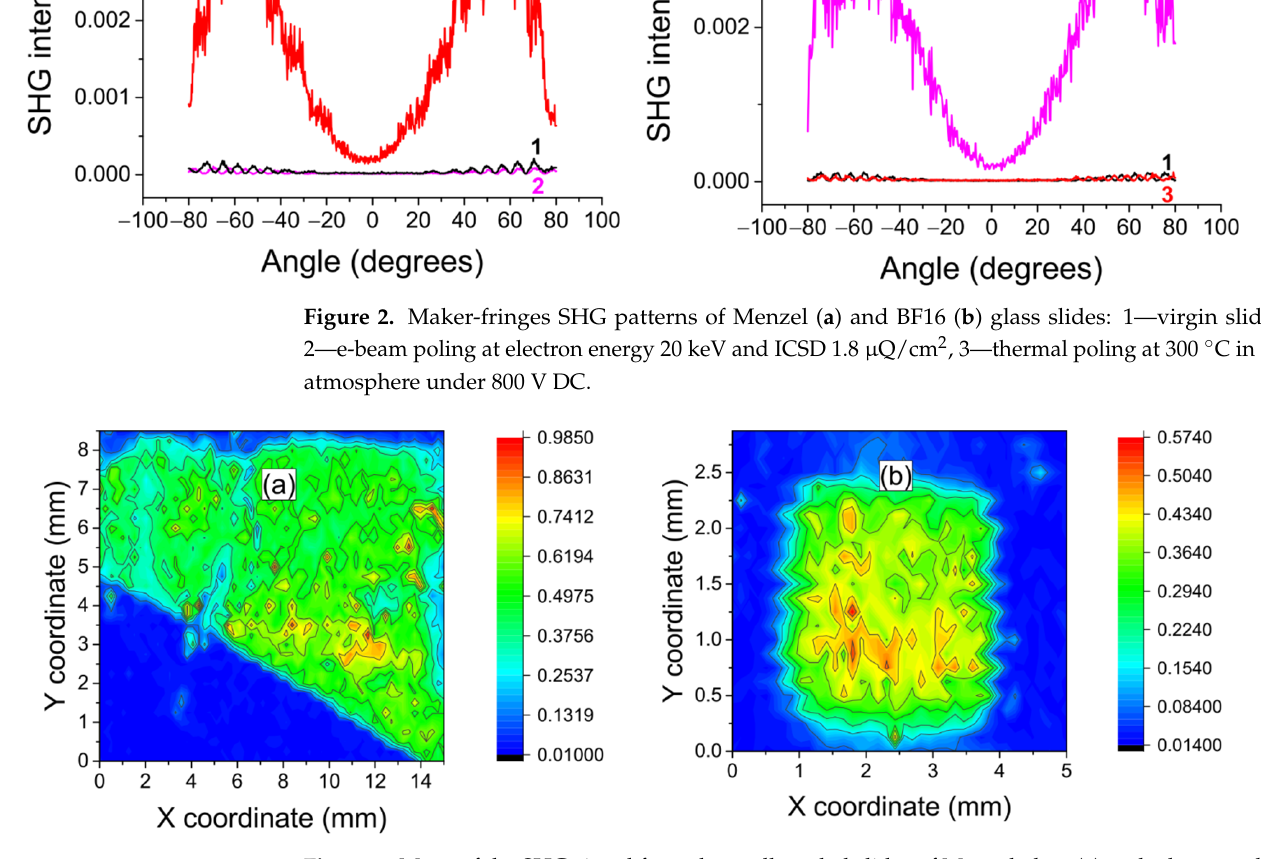
Figure 3. Maps of the SHG signal from thermally poled slides of Menzel glass ( a ) and e-beam-poled BF16 glass ( b ), obtained at the laser beam incidence angle of 63°. The color bars are in arbitrary units.